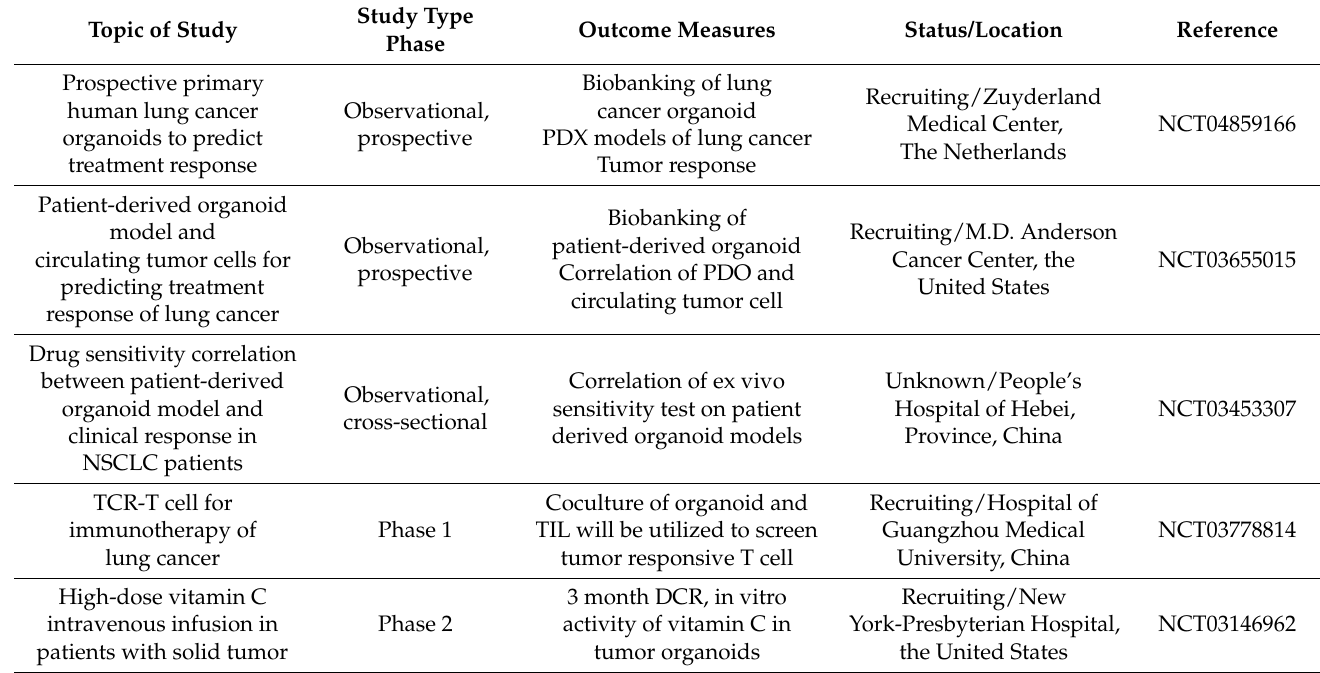
Table 4. Clinical trials that utilized lung cancer